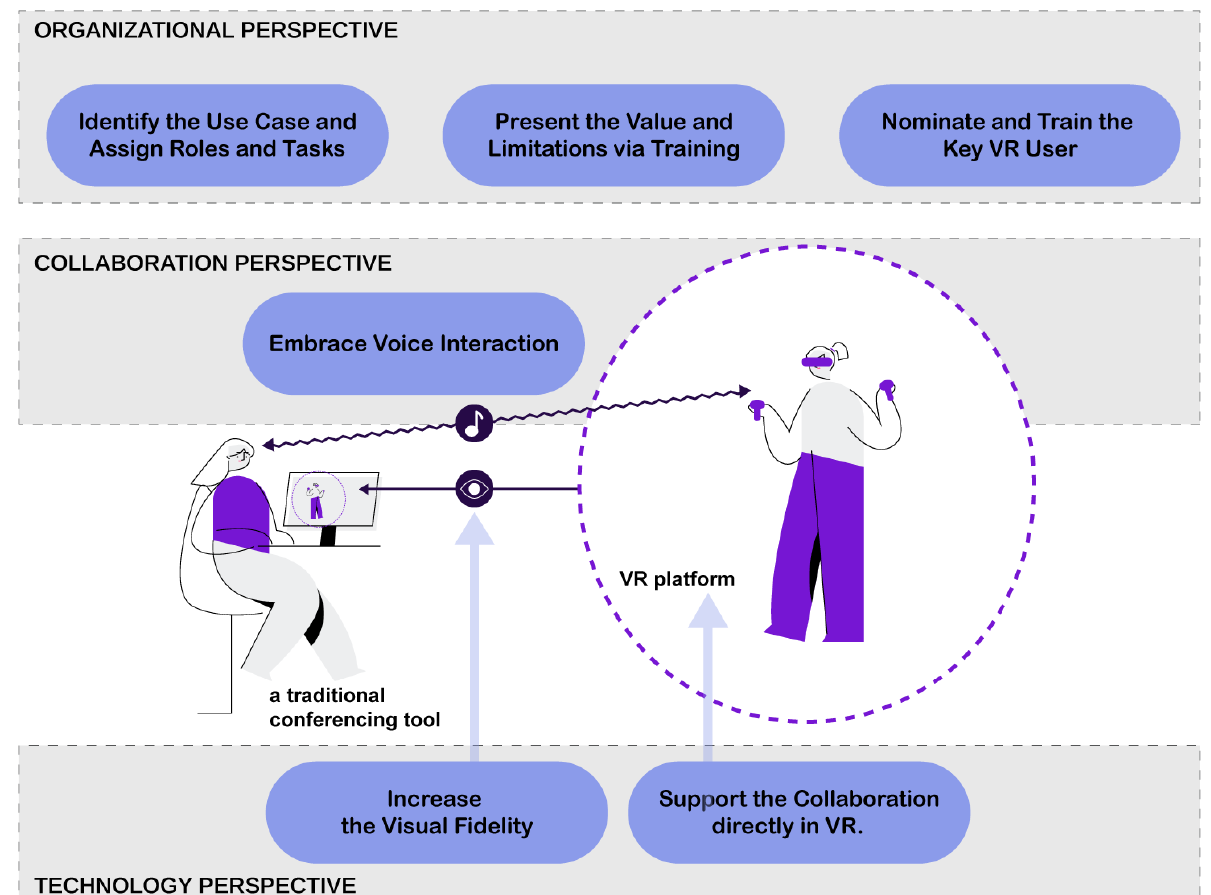
Figure 10. Guidelines on how to support asymmetry between VR and traditional conferencing